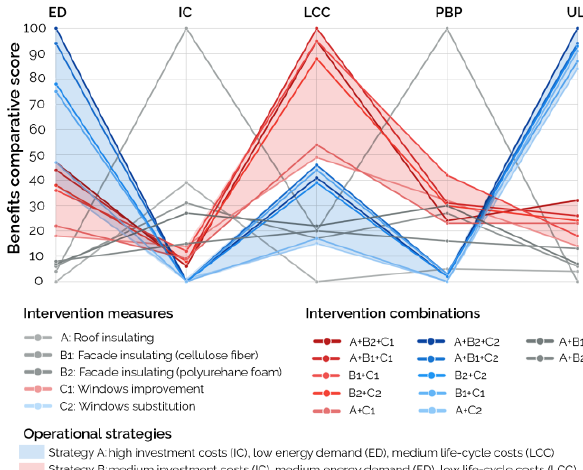
Figure 4. Multi-criteria analysis comparing different energy improvement solutions. Scores are expressed in terms of benefits from 0 to 100 with respect to five